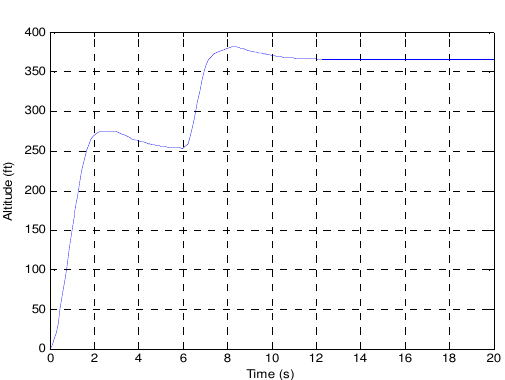
Fig . 8. Altitude with step elevator input.